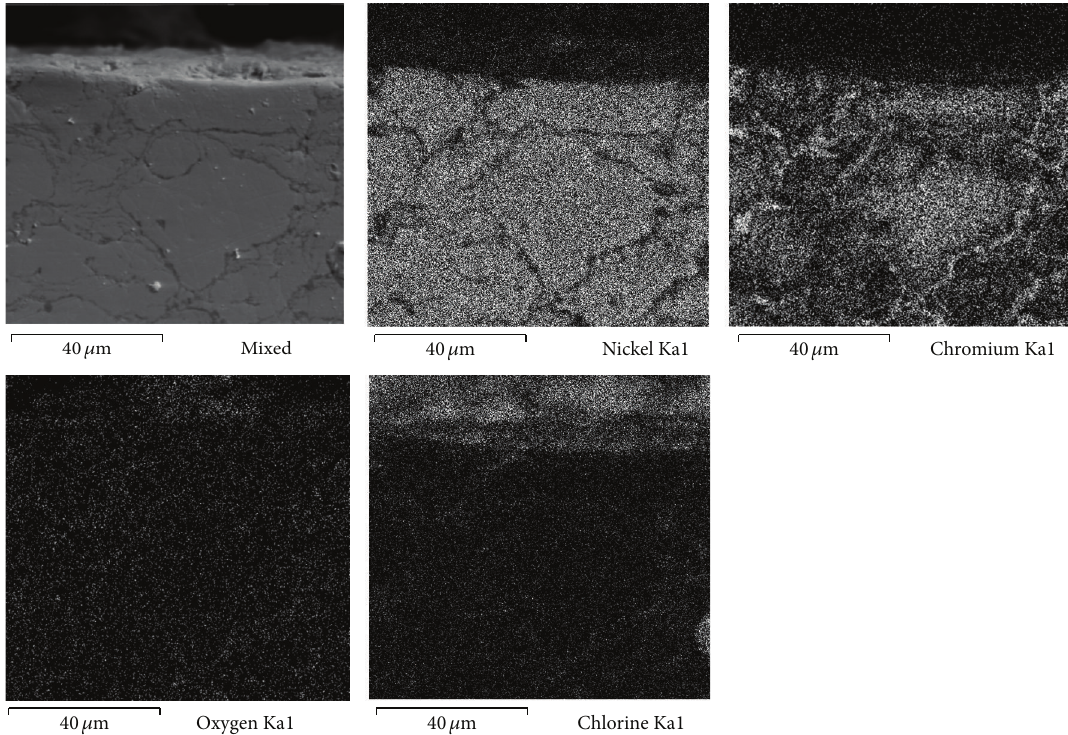
Figure 11: Cross-sectional aspect of the Ni20Cr as-grinded coating and elements distribution after corrosion test at 400 ∘